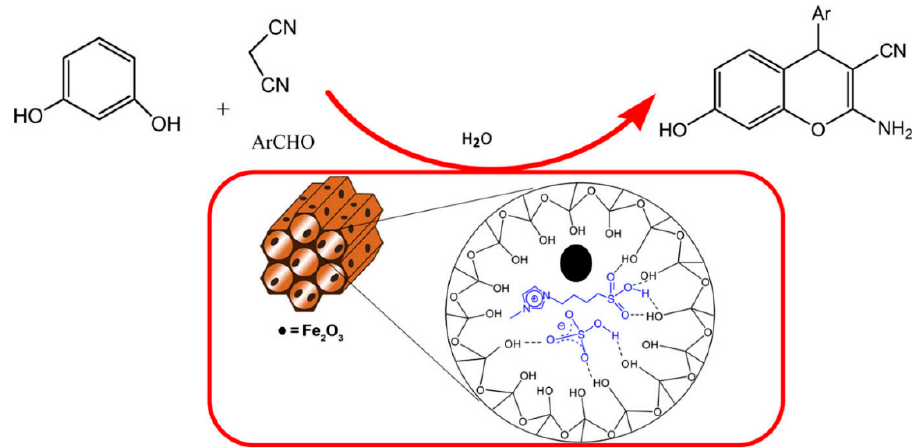
Figure 60. Synthesis of 2-amino-4H chromenes in the presence of ( α -Fe 2 O 3 )-MCM-41-DAIL catalyst. Reproduced with permission from [160]. Copyright 2016 Springer.